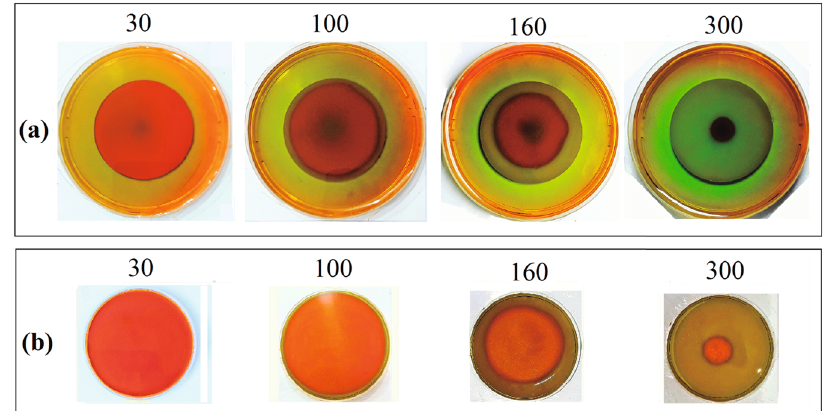
Fig. 4 Corrosion of CCL disc in the presence of magnetic fi eld using magnet bigger than CCL discs. a Pictures of the corrosion process on the CCL disc in the SMBC setup (Fig. 8a-I). b Pictures of the corrosion process on the CCL disc in the BMSC setup (Fig.